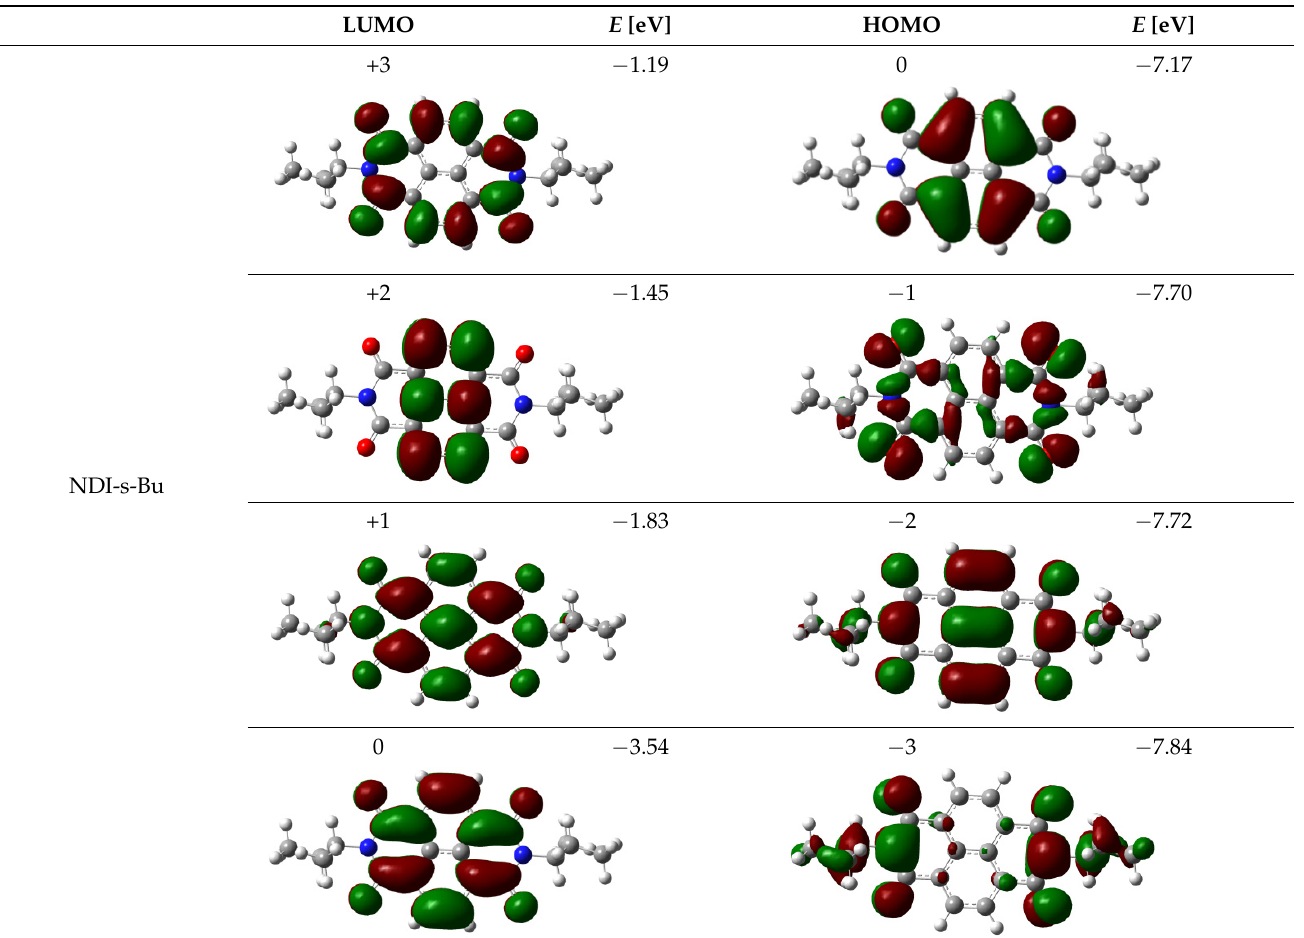
Table 2. Calculated projections of HOMO, LUMO and energetically nearest orbitals of both diimides. LUMO E [eV]